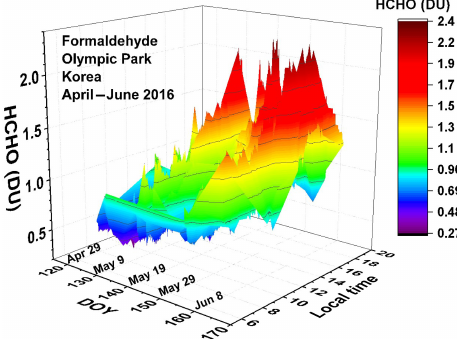
Figure 13. Pandora measured formaldehyde amounts vs. day of the year and local time for 29 April 2016 to 11 June 2016 in Olympic